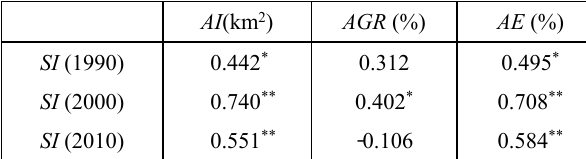
Figure.2 implies weighted distance index of each city based on network distance and gets spatial interpolation map of weighted distance index through IDW (Inverse Distance Weighted) method. A closer examination of Figure.3 reveals cities near regional center have higher urban expansion intensity (AI and AE). This trend, however, was fluctuated for cities far from regional center in the third period. Because of the limited scope